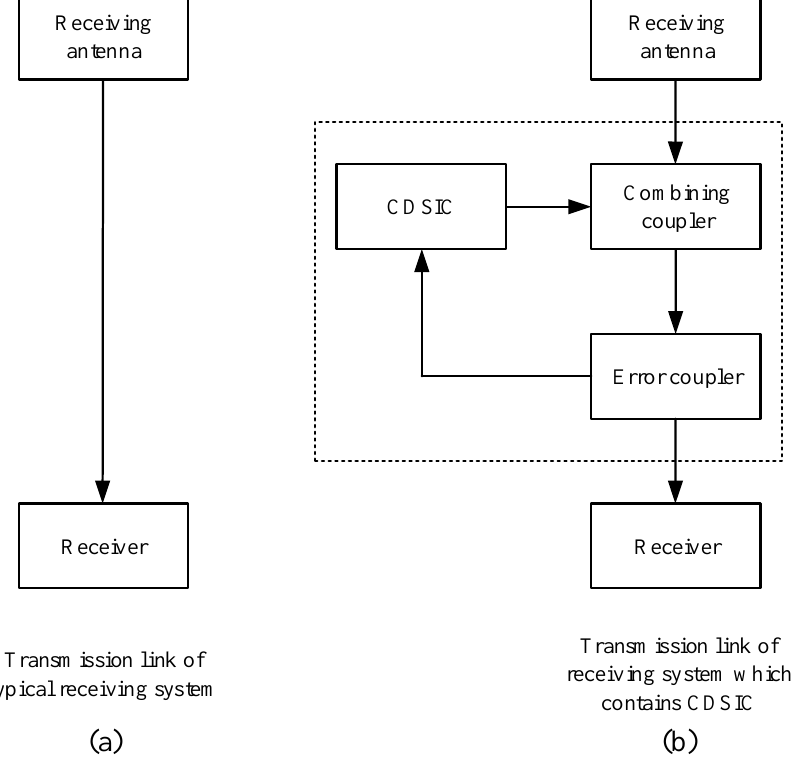
Figure 13. Typical receiving system and receiving system containing a CDSIC. Summarily, compared with the CDSIC, FDSIC has a relatively low complexity and smaller effects on the receiving system. However, CDSIC normally has a high ICR, since it is easier to precisely reconstruct the self-interference via